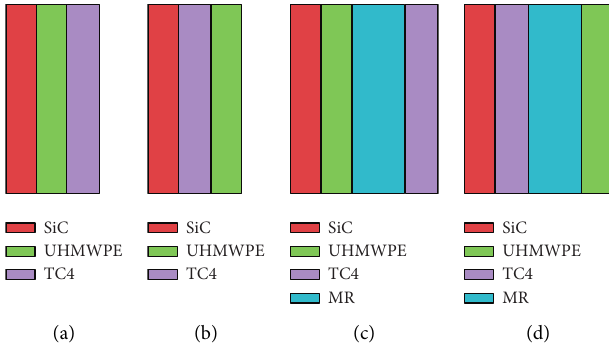
Figure 1: Four types of composite structure (a) SiC/UHMWPE/TC4; (b) SiC/TC4/UHMWPE; (c) SiC/UHMWPE/MR/TC4; (d) SiC/TC4/ MR/UHMWPE.